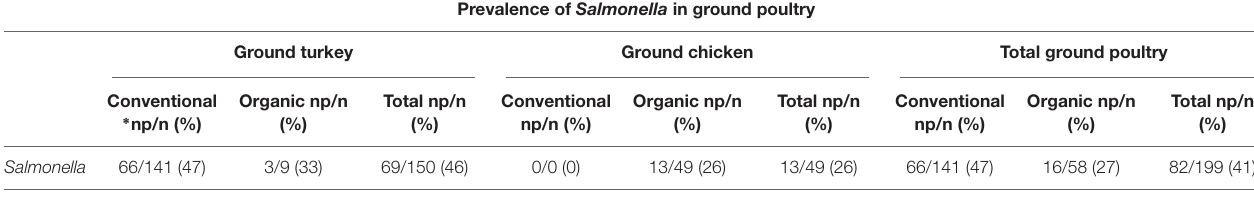
TABLE 1 | Prevalence of Salmonella in ground poultry samples collected in this study. Prevalence of Salmonella in ground poultry